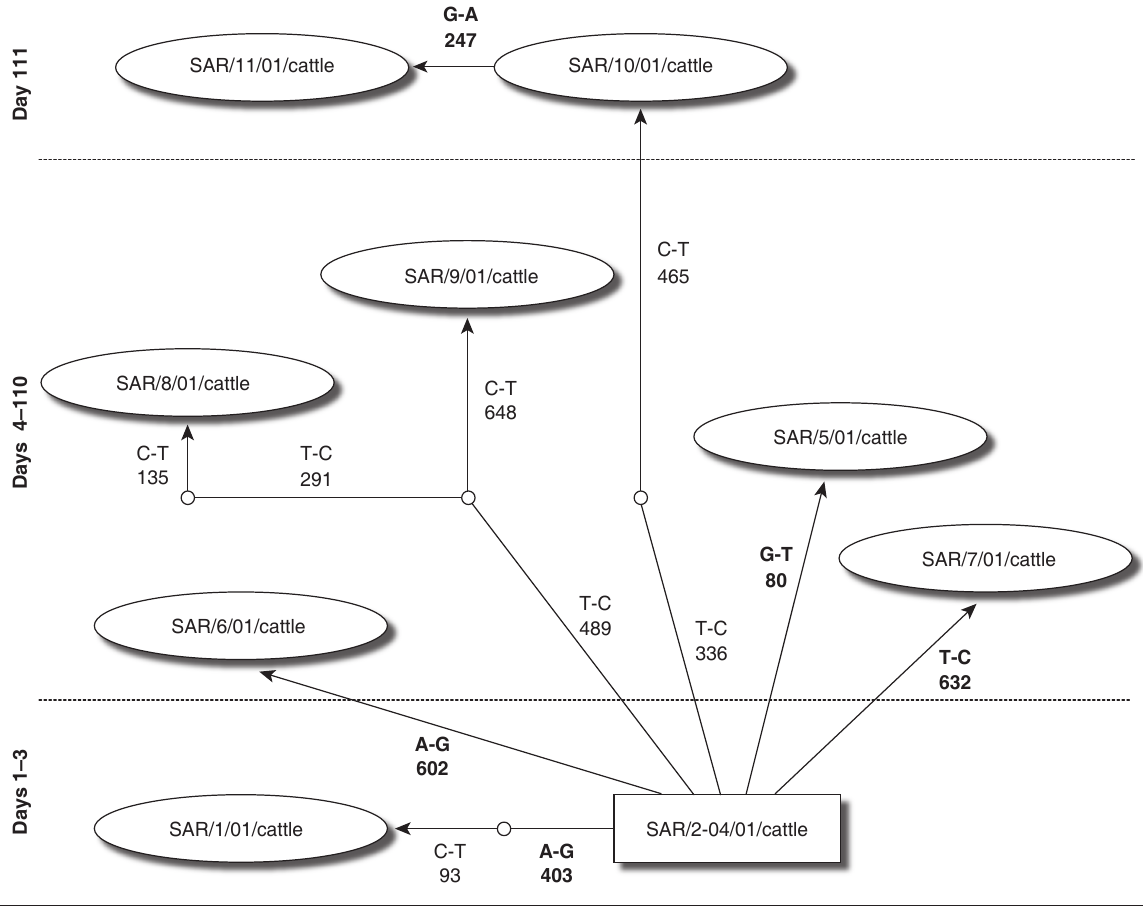
FIG. 3 The rooted cladogram supported by statistical parsimony in the program TCS. The square indicates the identified root of the genealogy. Small circles indicate genotypes that were not sampled. Nucleotide substitutions are labelled on the arrows (those in bold are non-synonymous). Where a genotype is removed from its putative ancestor by more than one mutational change, the order of these changes is